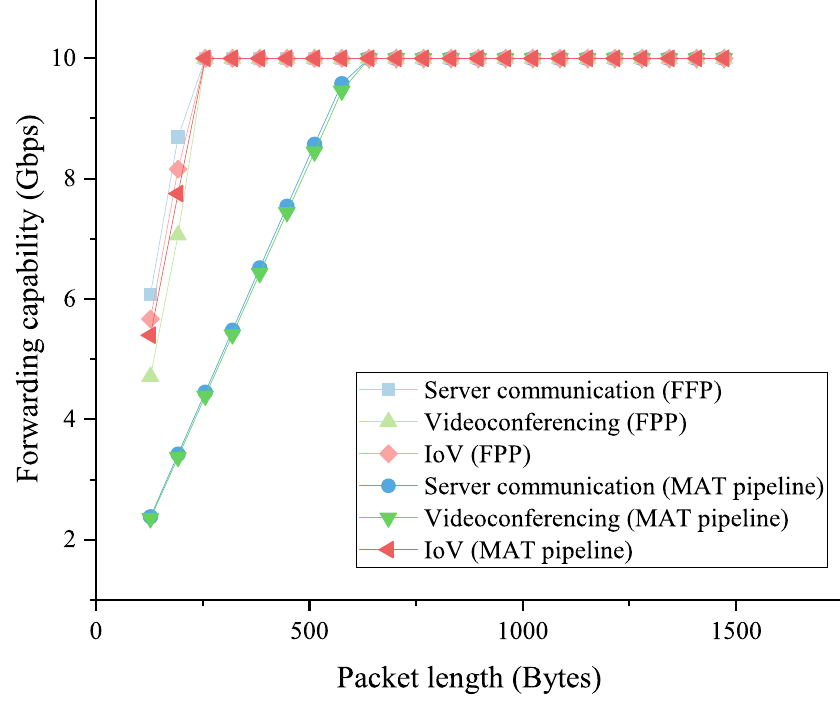
Figure 11. The low-latency traffic forwarding capabilities of the FFP and the MAT pipeline in the native POF